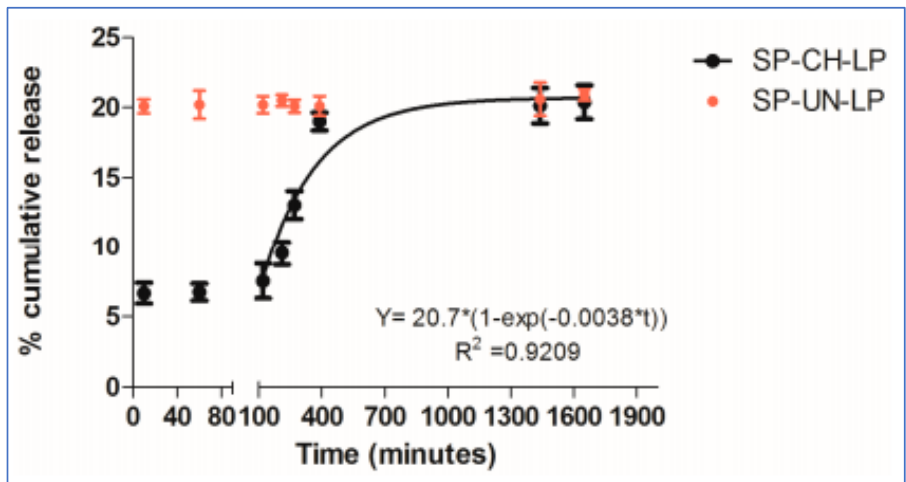
Figure 6. In vitro release of drug substance from chitosan-coated and uncoated liposomes in PBS (pH 7.4; 37 °C; n = 3) [35].